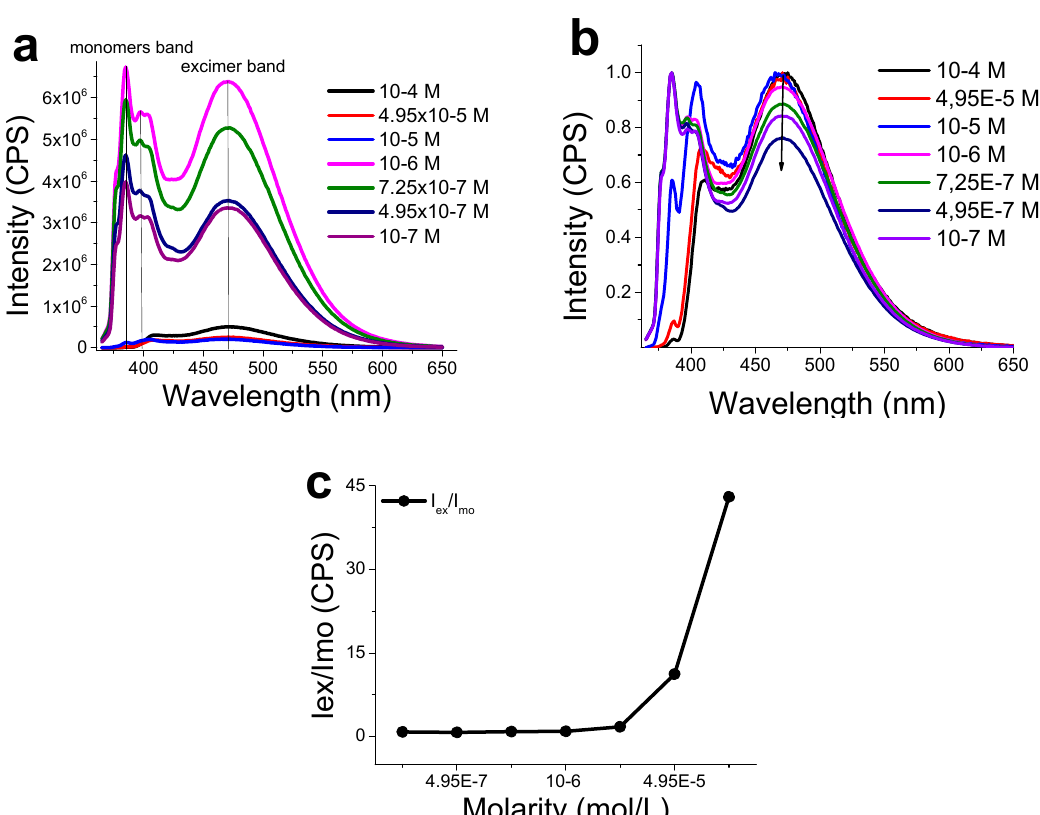
Figure 4. ( a ) Overlay of fluorescent emission spectra at different molarities of TP9-PYR(6) in toluene. ( b ) Normalized emission intensity. ( c ) Ratio between excimer and monomer emission as function of molarity.